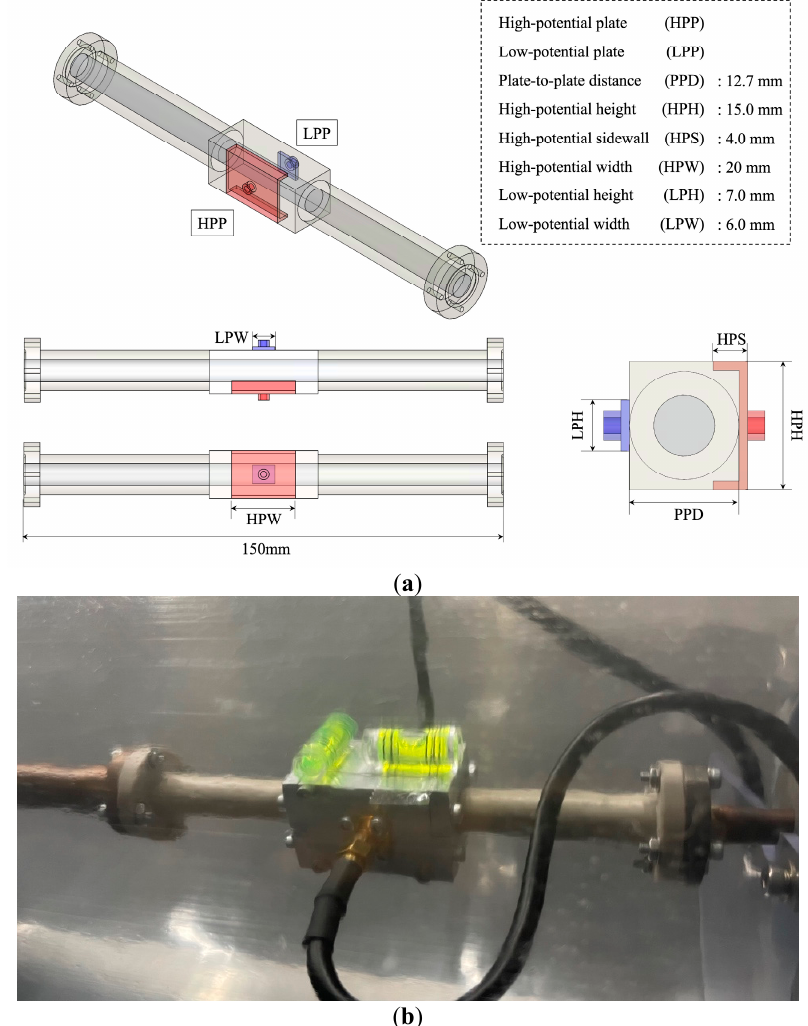
Figure 4. Capacitance sensor optimized for R32; inner diameter: 7.1 mm; ( a ) design parameters and the geometry; ( b ) mounted capacitance sensor inside the vacuum insulator.